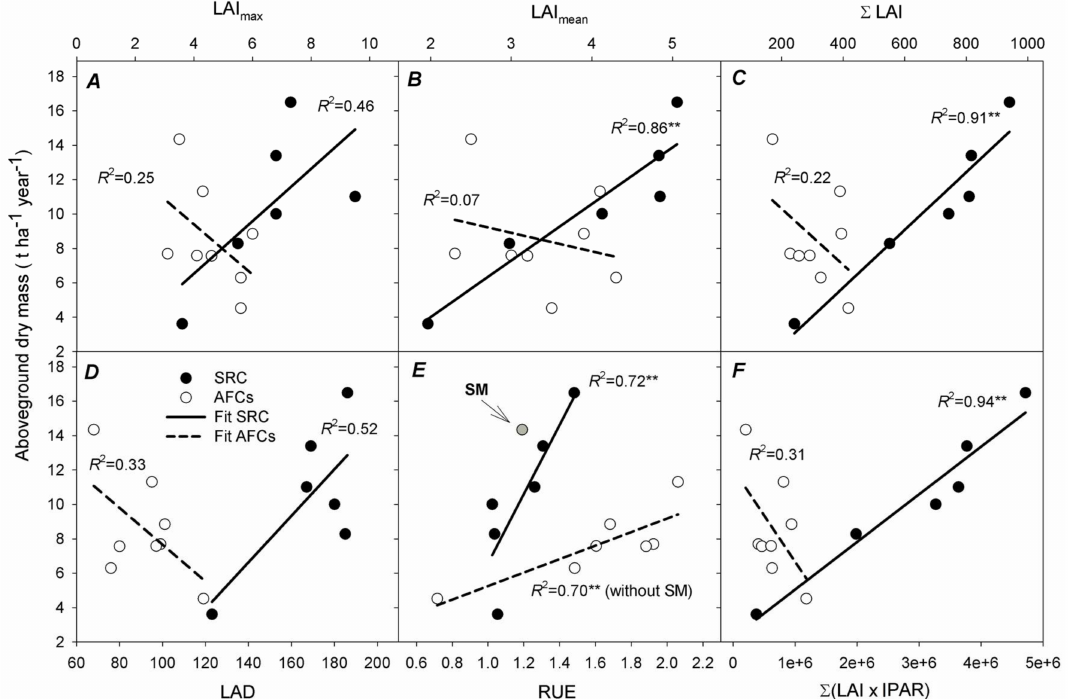
Figure 4. The relationships between aboveground dry mass (AGDM) production and: ( A ) the maximum leaf area index (LAI max ); ( B ) the mean LAI (LAI mean ); ( C ) the sum of LAI ( ∑ LAI); ( D ) the leaf area duration (LAD); ( E ) the radiation use efficiency (RUE); and ( F ) ∑ (LAI × IPAR) (absorbed photosynthetically active radiation) in SRC poplar clone J-105 and AFCs, respectively. Note: ** significant Pearson correlation coefficients at